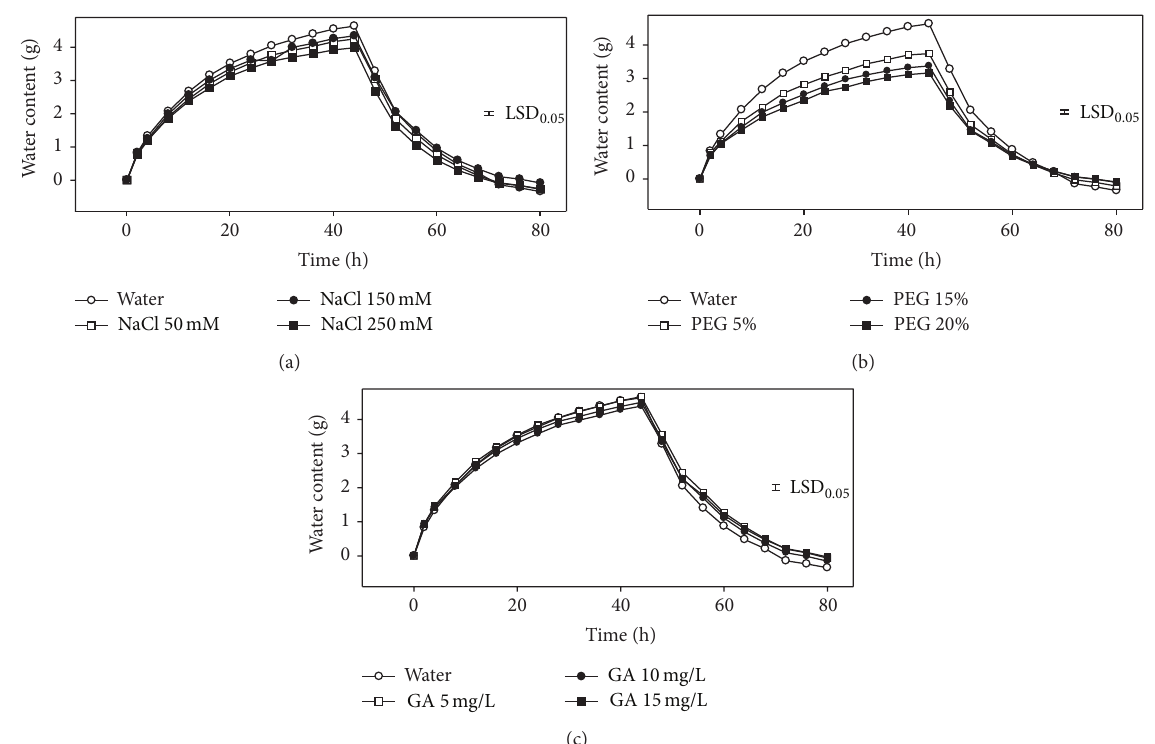
Figure 1: Effects of pretreatment reagents on water intake under priming cycle ( 𝑛 = 4